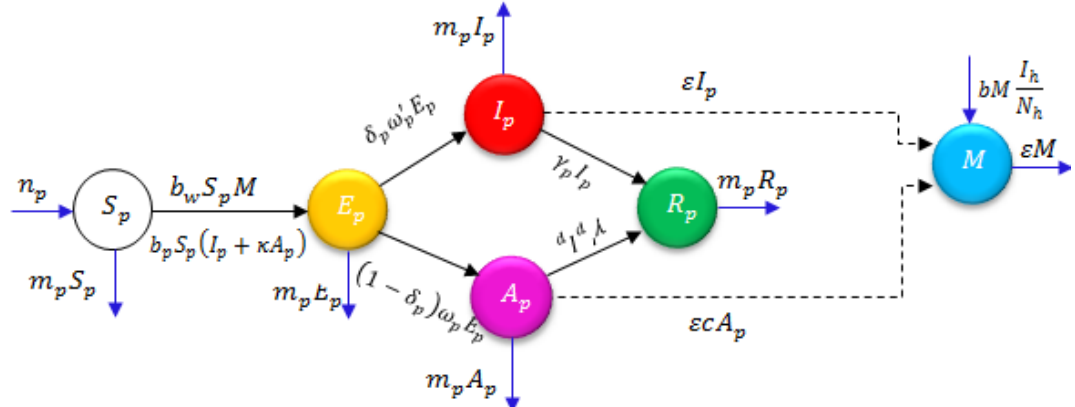
Figure 1. Flow chart of the above-described model [20].